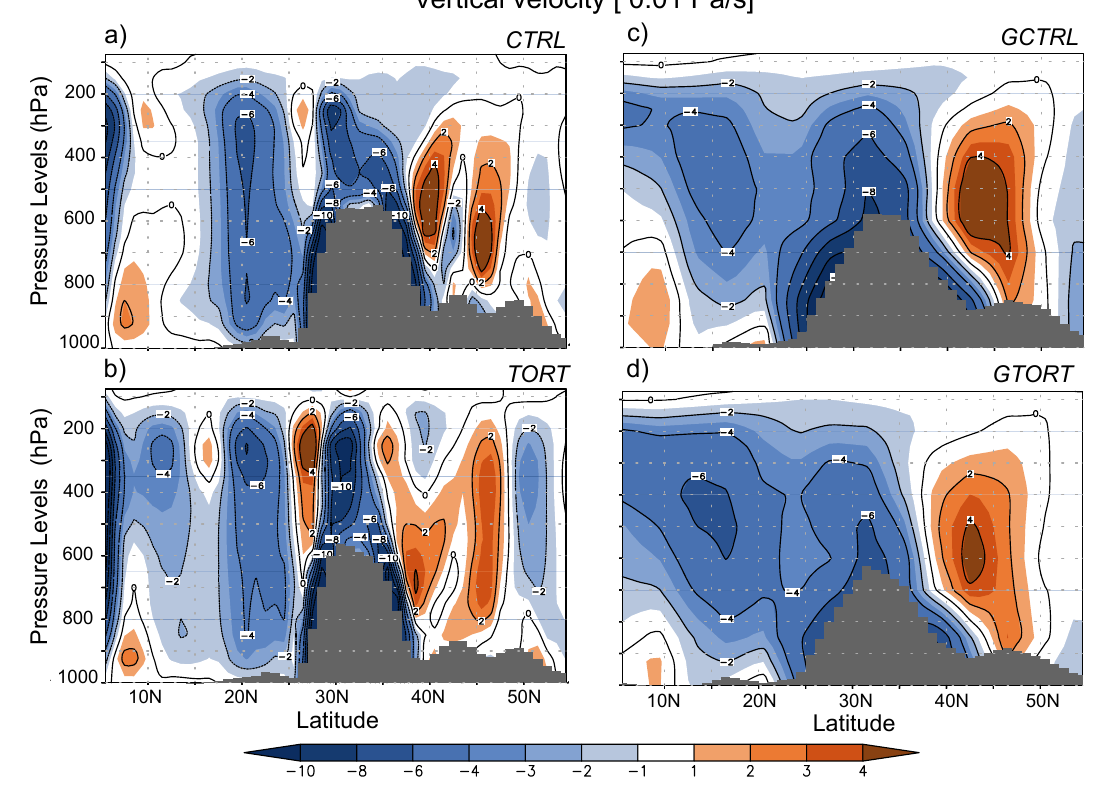
Fig. 8. Zonal averaged vertical wind velocity (10 − 2 Pas − 1 ) over longitude between 80 ◦ E and 95 ◦ E in the summer season (JJA). (a) CTRL, (b) TORT, (c) GCTRL, (d) GTORT. The blue colour denotes rising motion and the red colour denotes sinking motion. The grid cells with pressure larger than the surface pressure are shaded by dark gray